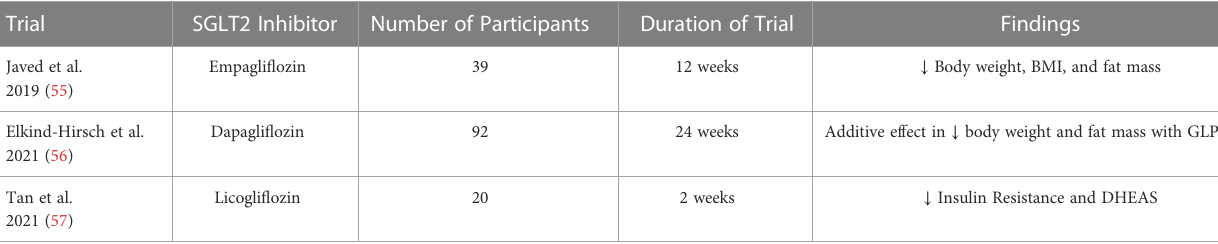
TABLE 1 Clinical trials of SGLT2 inhibitors in